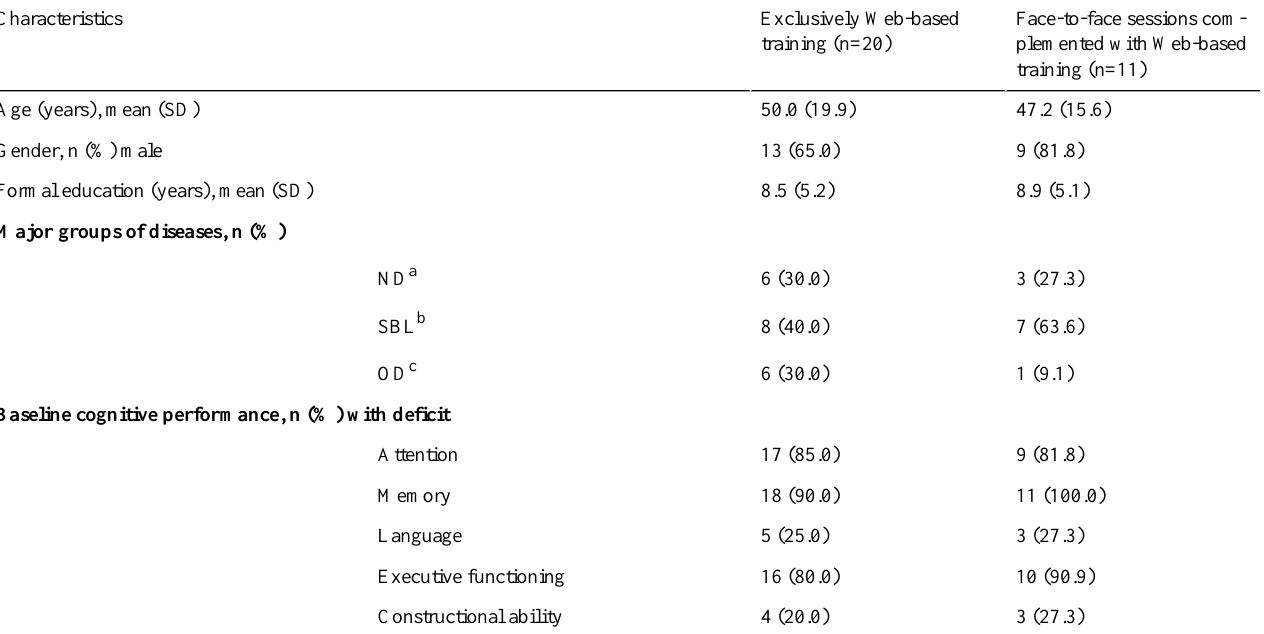
Table 3. Demographic characteristics of the groups used for analysis of the impact of face-to-face